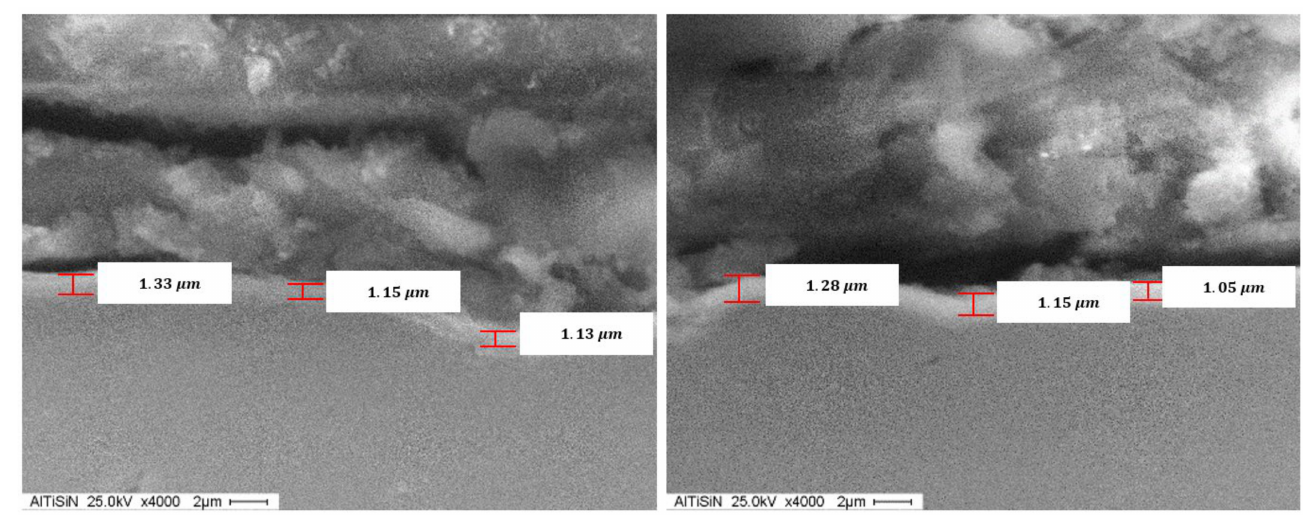
Figure 13. SEM of the AlTiSiN coating.